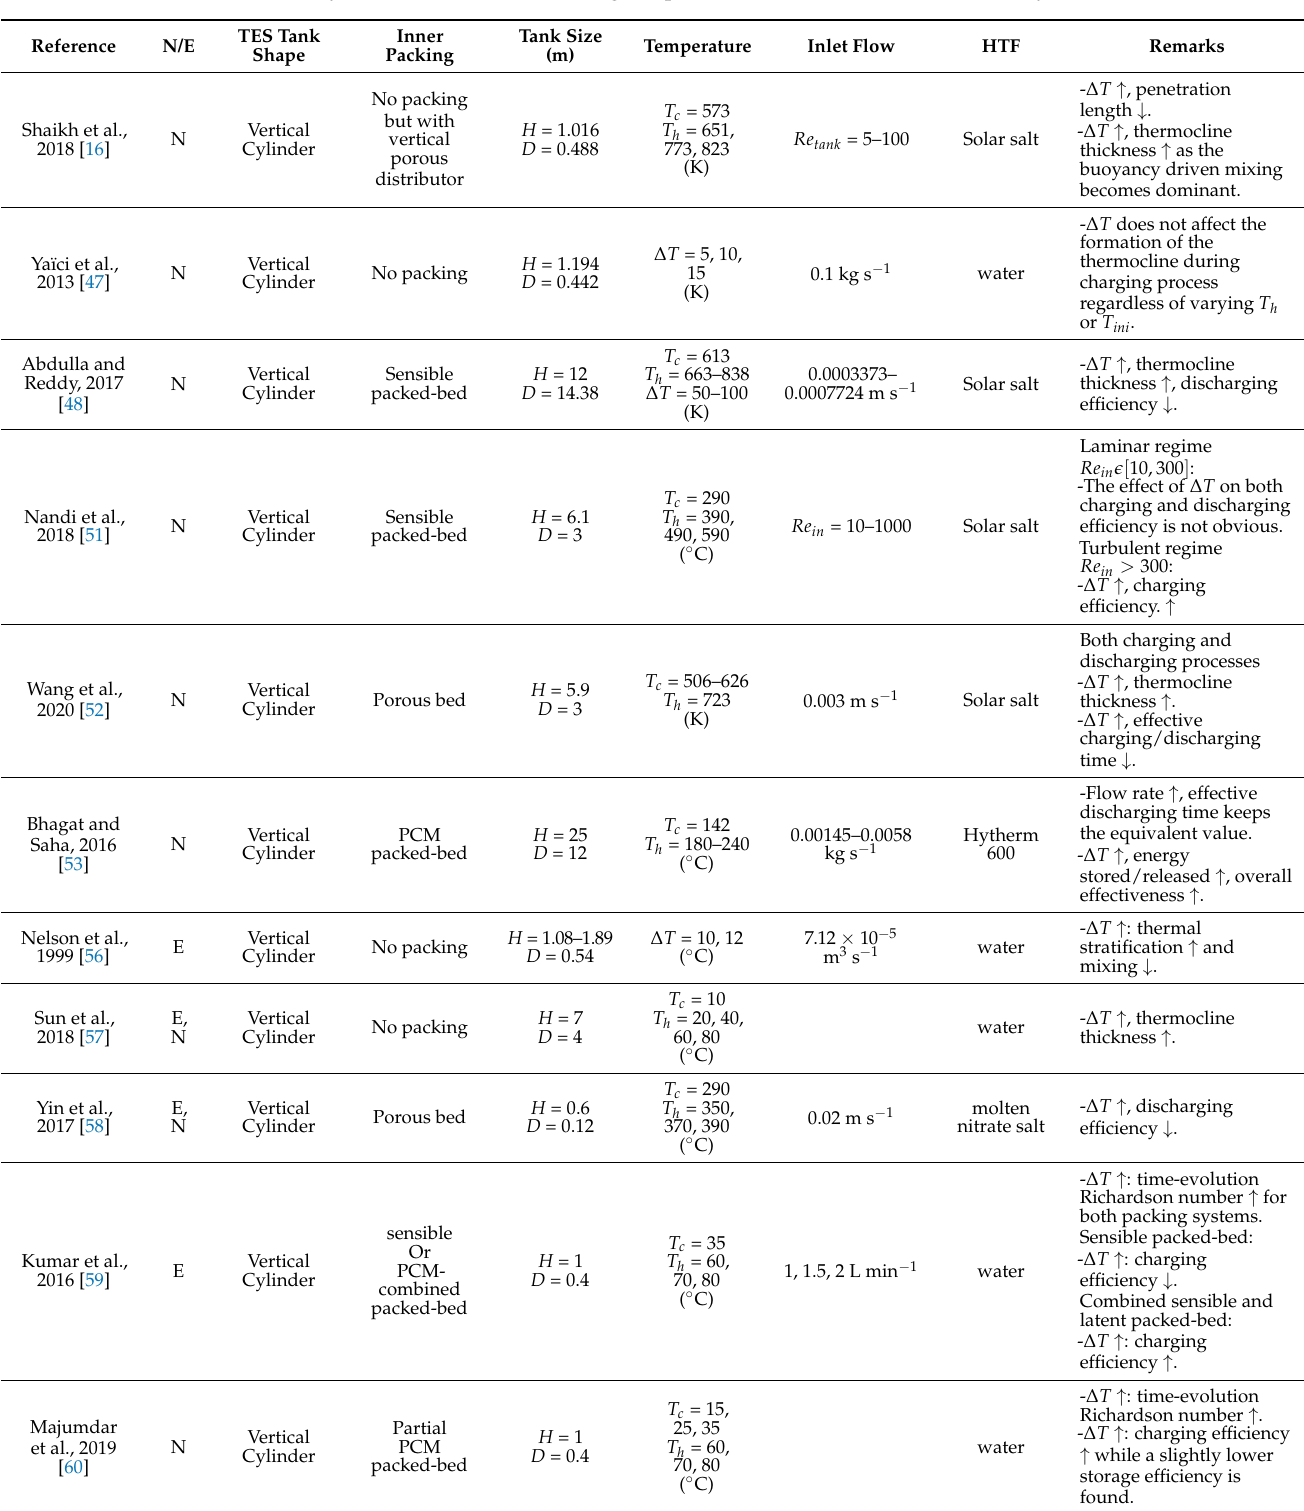
Table 4. Study on the influence of working temperature for thermocline–based TES